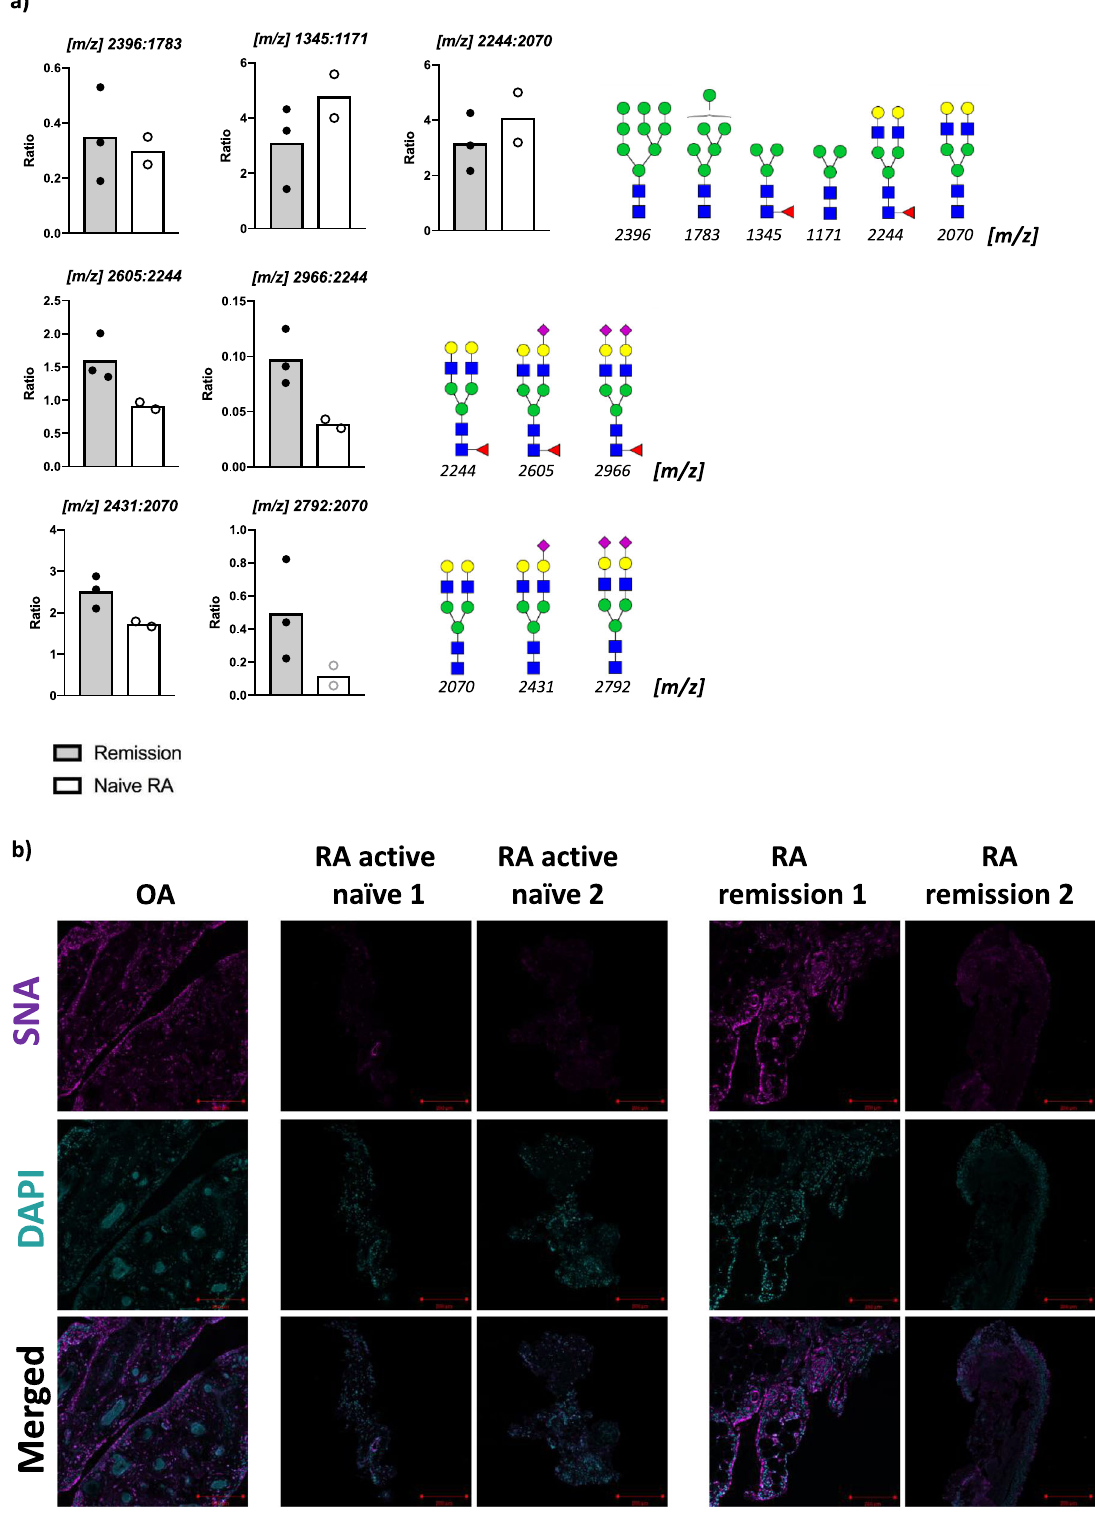
Fig. 8 Levels of sialylation correlate with disease stages and pathotypes of human RA. a Synovial fi broblasts were expanded from human biopsies from n = 2 naive RA patients (not exposed to any disease-modifying anti-rheumatic drug) and n = 3 RA patients in sustained clinical and imaging remission achieved with c-DMARDs + TNF-inhibitor combination therapy. N-glycans were isolated and subjected to MALDI-TOF MS analysis. Relative intensity was used to calculate the ratio of expression of the indicated paired glycans. Glycan structures are designated by their m / z value. b Synovium from OA, and naive and remission RA patients were stained with biotinylated SNA and Alexa-647-conjugated streptavidin (magenta). DAPI (cyan) was used to stain cell nuclei. Images were acquired with a confocal microscope LSM 880. Results are from one single experiment, OA n = 1, active RA = 2, remission RA n = 2. Each image represents one individual patient. Scale bars: 200 μ